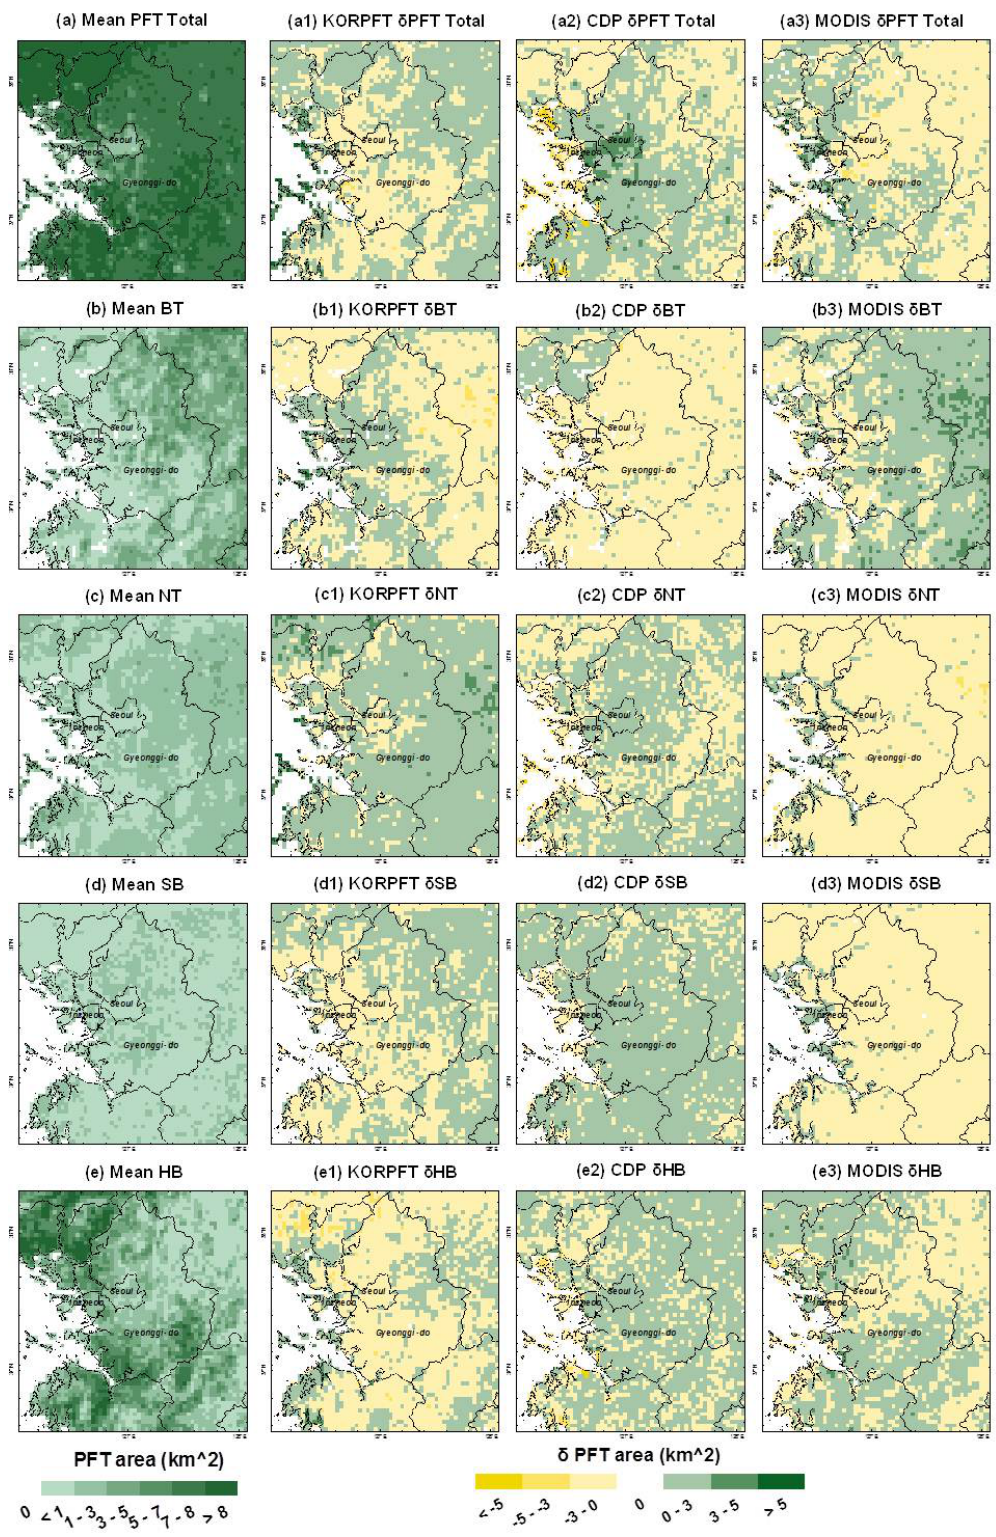
Figure 4. Spatial distribution of the PFT area deviations for each PFT scenario. The mean spatial distributions for PFT total and the PFT classes (BT, NT, SB, and HB) were derived by averaging the three different distribution data